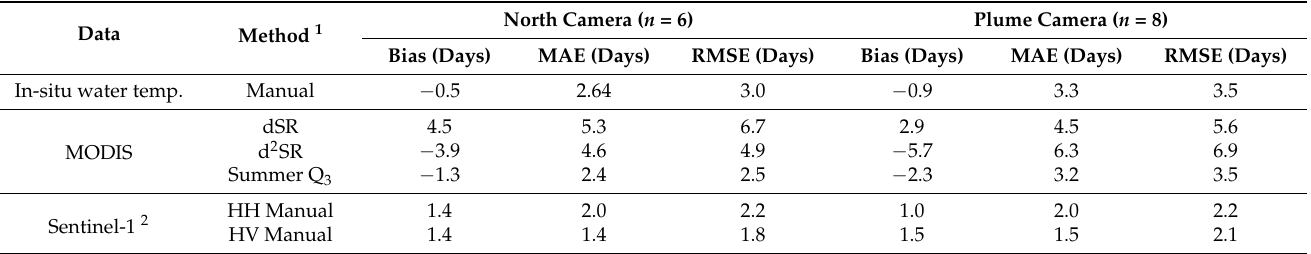
Table 1. Agreement between BUE dates from the camera images and other BUE estimation methods.